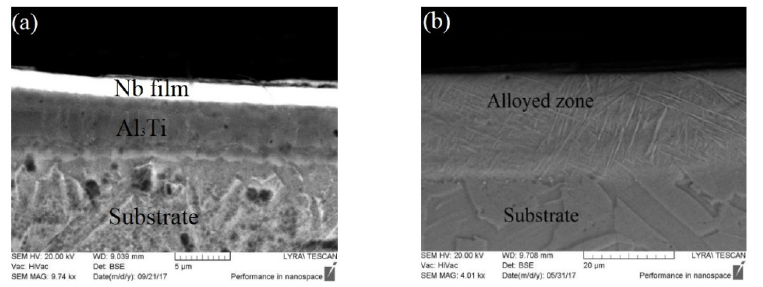
Figure 11. Cross-sectional SEM images of Ti–Al–Nb surface alloys, formed by electron-beam surface